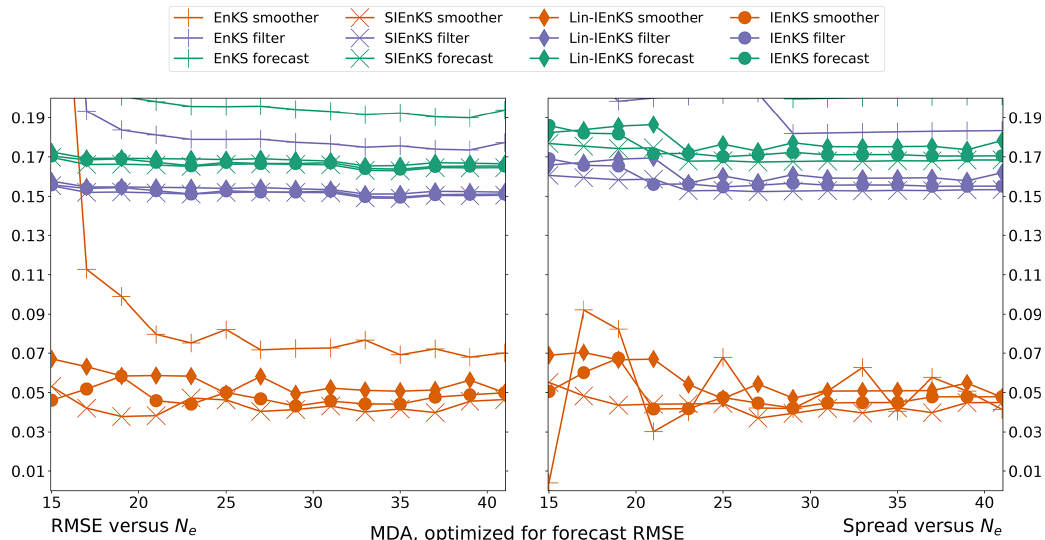
Figure 12. MDA configuration. RMSE and spread versus the ensemble size N e . Lag and inflation are optimized for a minimum forecast RMSE in Fig. 10.